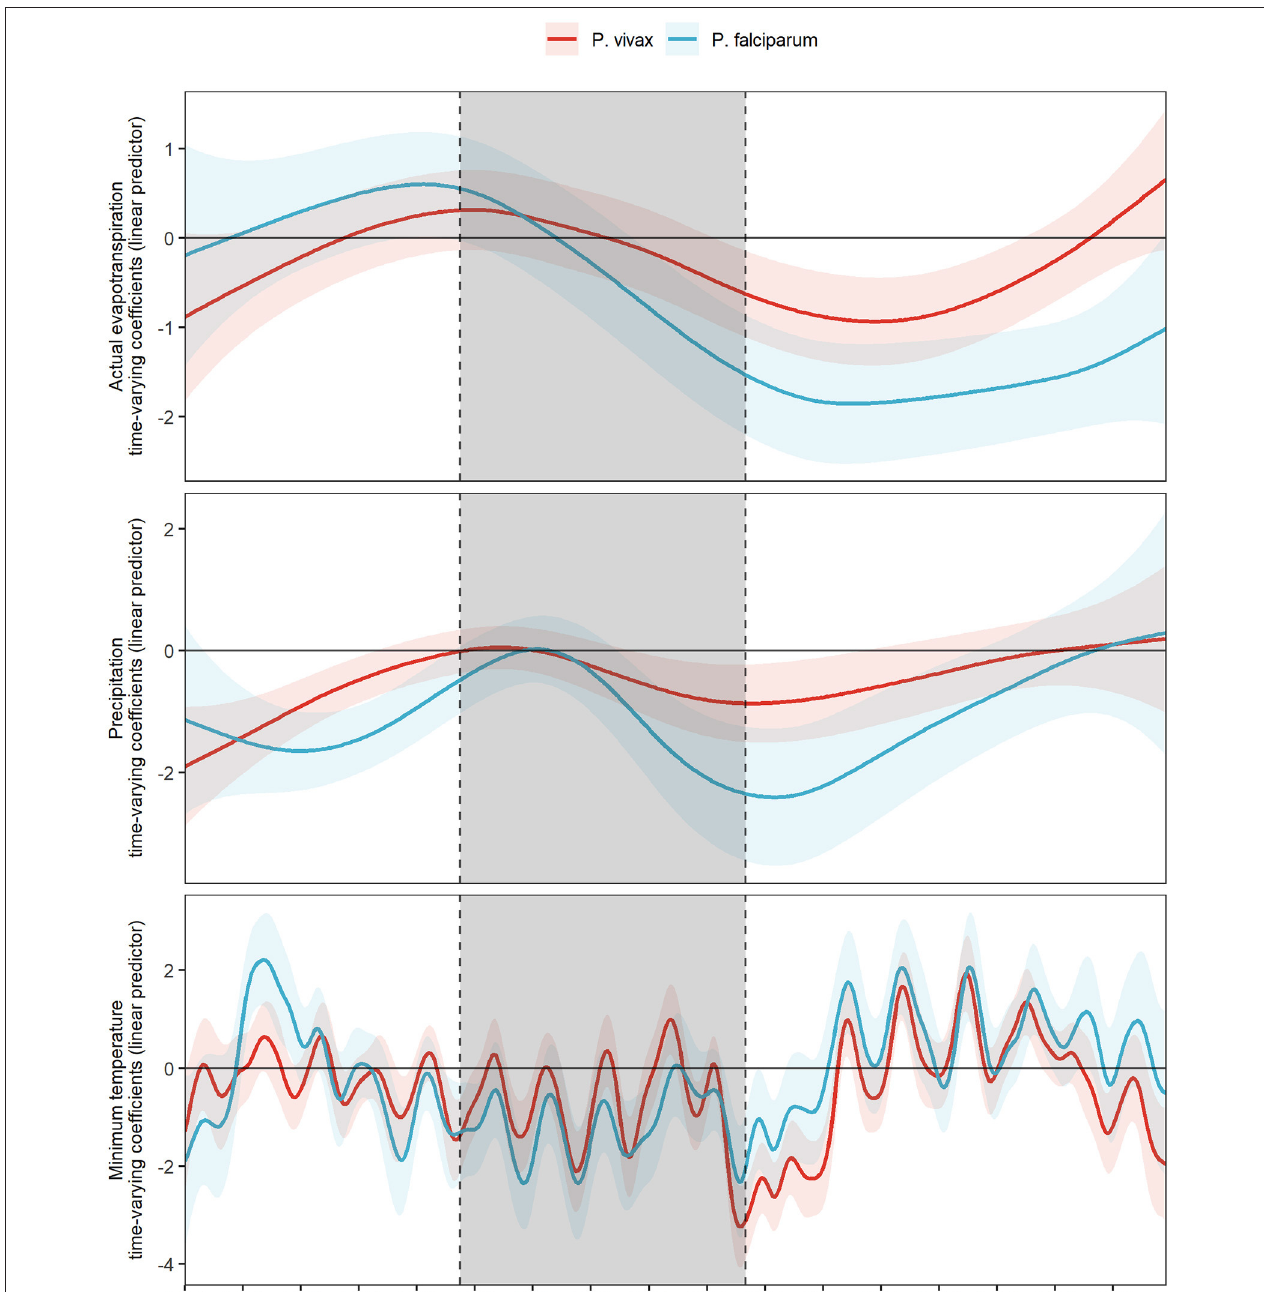
FIGURE 2 | Fitted time-varying meteorological effects on MIR by parasite species. Fitted time-varying meteorological effects due to P. vivax (red) and P. falciparum (light blue) and their 95% CI (shading of each colored curve). The period shaded in gray represents the PAMAFRO intervention.